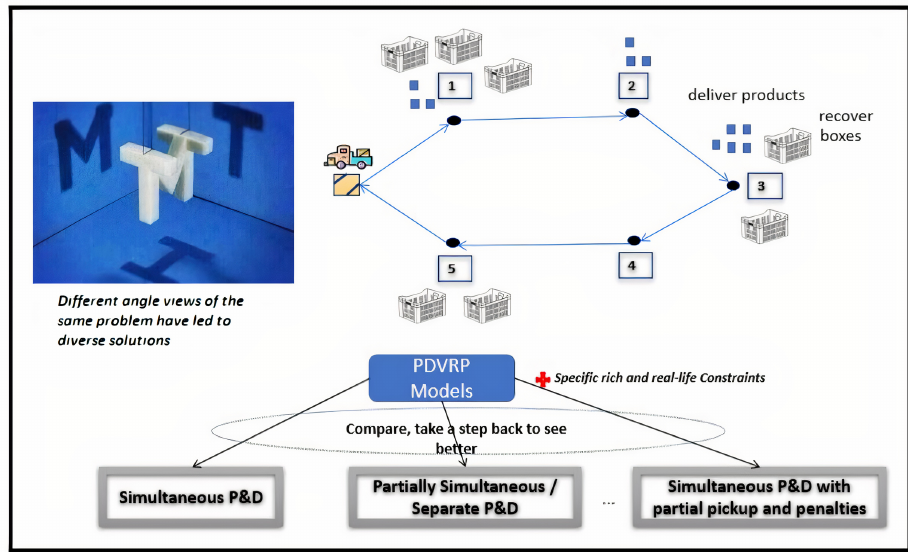
Figure 1. Multiple readings of the same